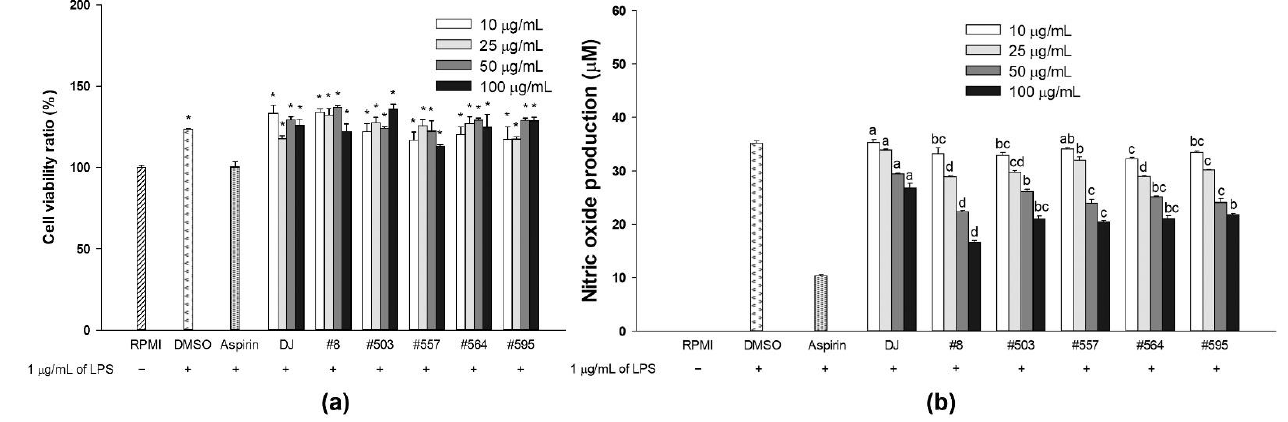
Figure 2. Effects of transgenic rice seed extracts on LPS-stimulated RAW264.7 cells. Effects on ( a